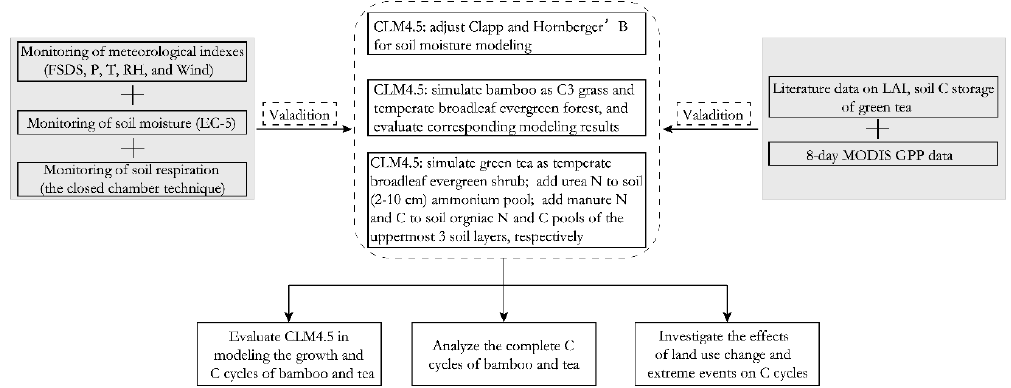
Figure 4 . Schematic of the method used in the study. FSDS, P, T, RH, and Wind represent incoming solar radiation, rainfall, air temperature, relative humidity, and wind speed, respectively. solar radiation, rainfall, air temperature, relative humidity, and wind speed,